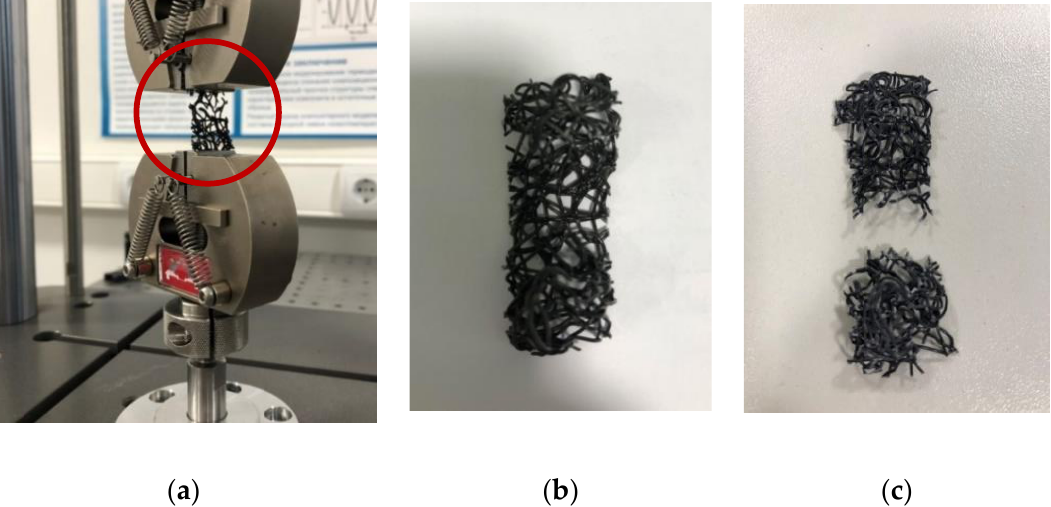
Figure 7. Rupture test of the erosion control geomat sample using ( a ) the Instron ElectroPuls E1000 and a ( b ) virgin and a ( c ) broken sample.